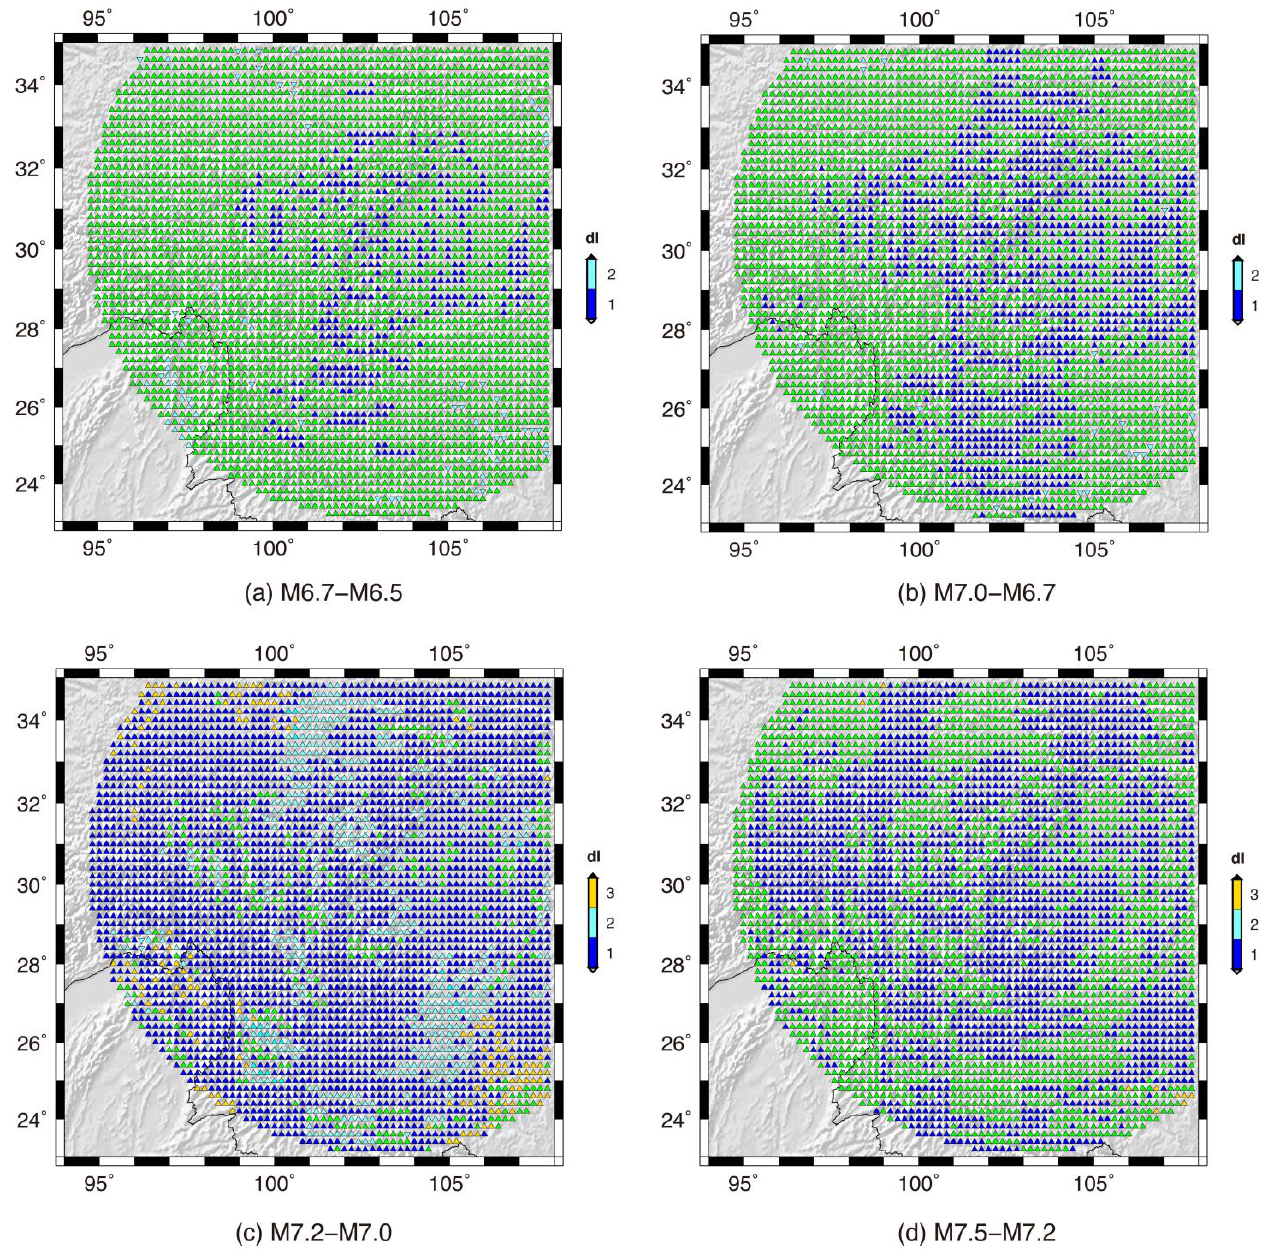
Figure 5. The differences of MMI values obtained considering computations of four scenarios with varying magnitude values (magnitude step is equal to 0.2/0.3) whereas the other focal parameters are fixed. Distribution of differences between ( a ) magnitude 6.7 and 6.5, ( b ) magnitude 7.0 and 6.7, ( c ) magnitude 7.2 and 7.0, and ( d ) magnitude 7.5 and 7.2. The green triangles indicate the different is zero.